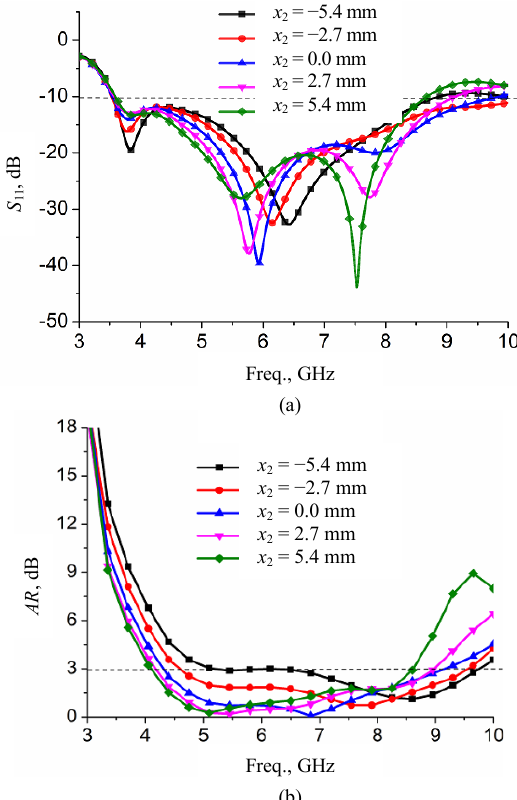
Fig. 8. Effect of ‘ x 2 ’ on impedance bandwidth and axial